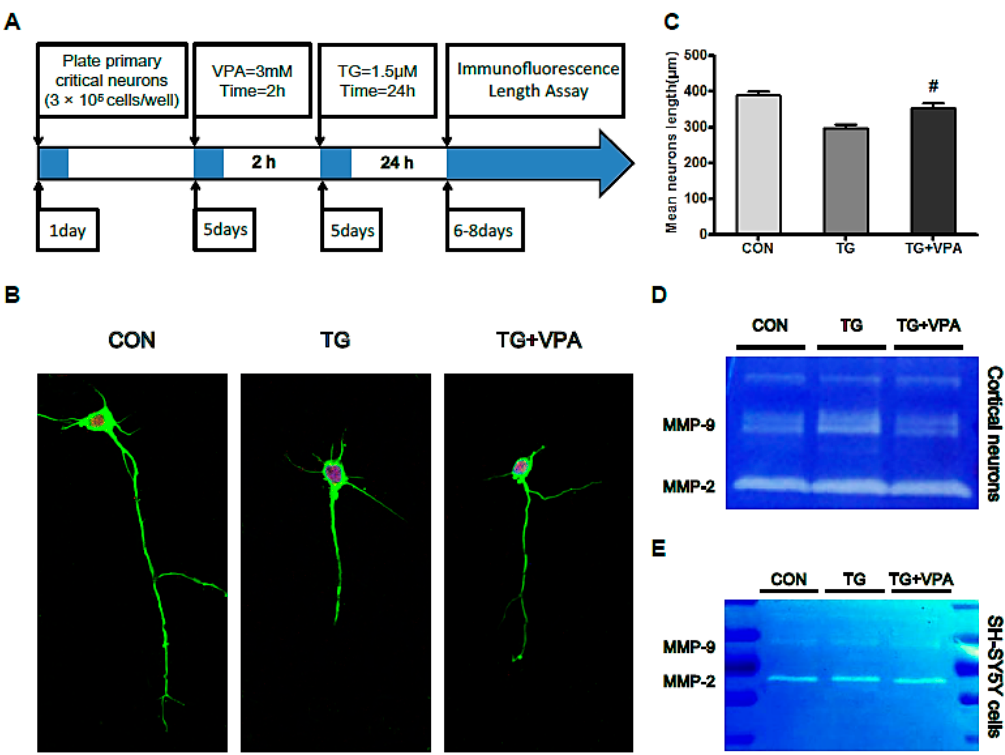
Figure 8. VPA plays a neuroprotection role in primary cortical neurons and affects matrix metalloproteinase (MMP) family protein activation. ( A ) The protocol of the experiment in primary cortical neurons; ( B ) Immunofluorescence of primary cortical neurons after TG treatment. β -IIItublin ( green ); NeuN ( red ); the nuclear was labeled by DAPI ( blue ). Magnification was 60 × ; ( C ) The mean neurite length of primary cortical neurons, # p < 0.05 versus the TG group; ( D , E ) Gelatin zymography for the cell medium in primary cortical neurons and neuronal cells line SH-SY5Y. Data are the mean values ± SEM, n = 3.